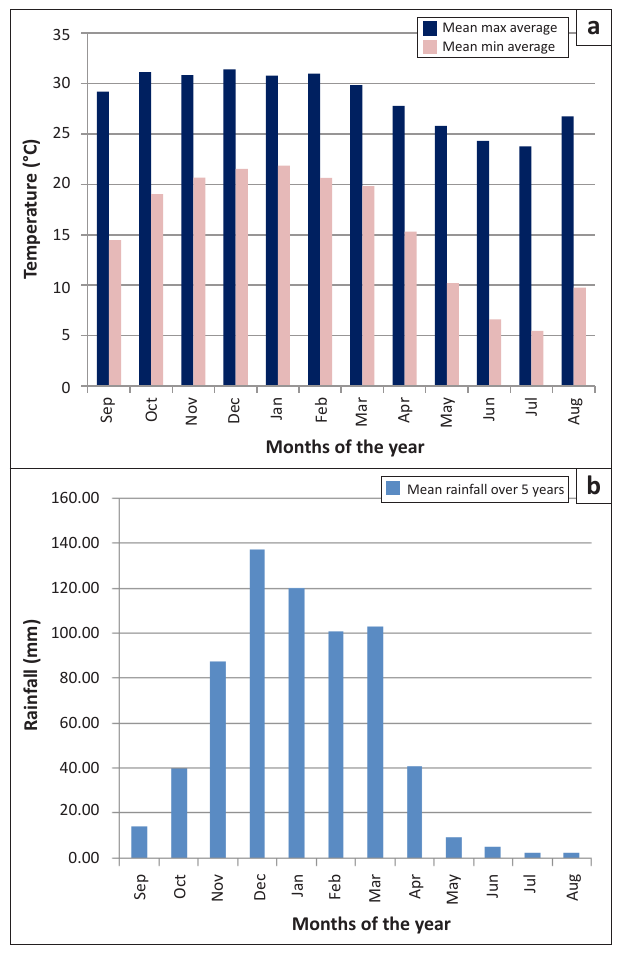
FIGURE 1: Temperatures and rainfall in the study area from September 2003 to August 2008, (a) mean minimum and maximum temperatures and (b)